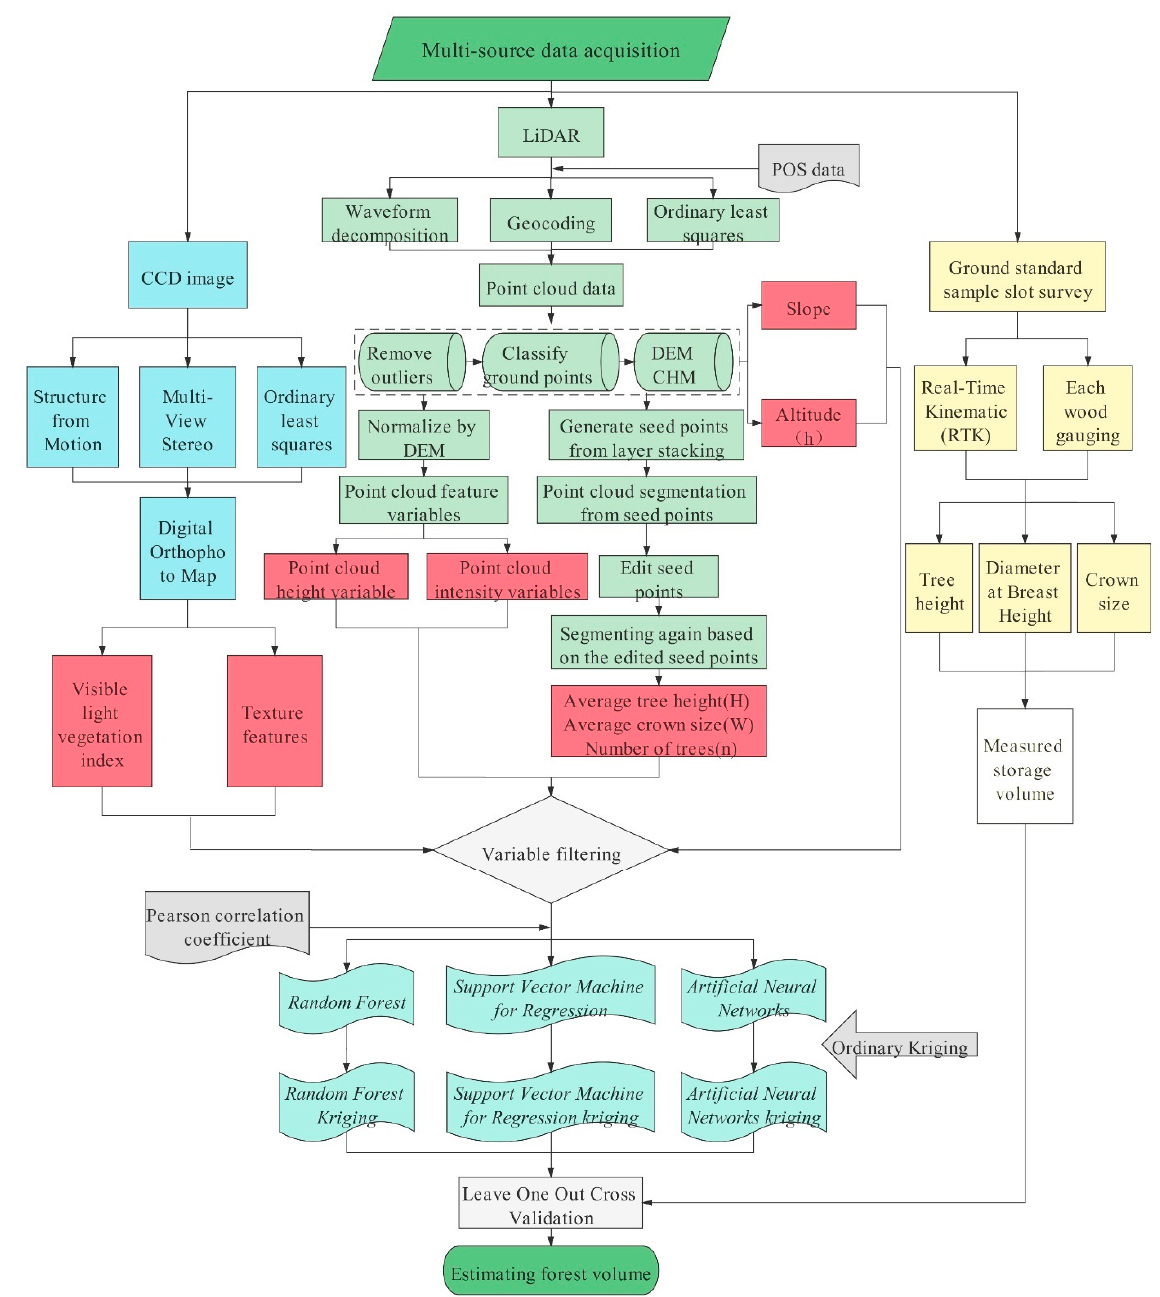
Figure 4. Technology roadmap. Multi-source data are used to estimate forest volume, where blue is the processing method of the CCD image data source; green is the processing method of the LiDAR data source; yellow is the processing method of the ground standard sample data source; red represents the independent variables; white on the left represents the measured value; blue–green represents the estimation model.